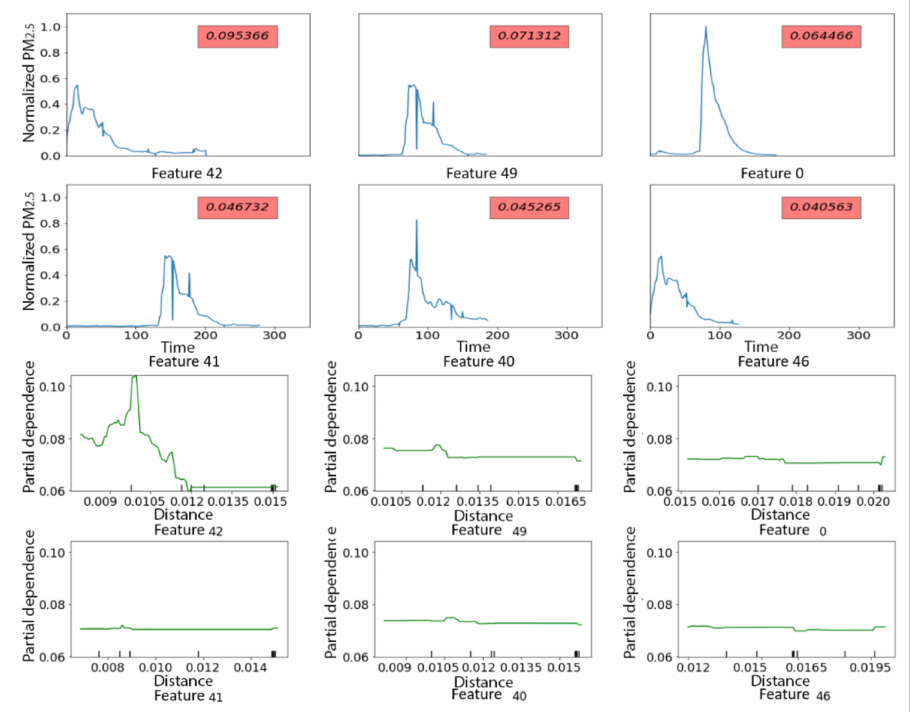
Figure 15. Top 6 shapelets predicting days with vs. without rescue medication in PRISMS based on residential indoor PM 2.5 time series. Y-axis of partial independence plots: predicted probability. Red label in shapelet plots: feature importance value. Top panels display the shapelets along with their feature importance and bottom panels display partial dependence plots with x-axes representing the minimum distance to the shapelet and y-axies representing predicted probability of rescue medication use (vs. no